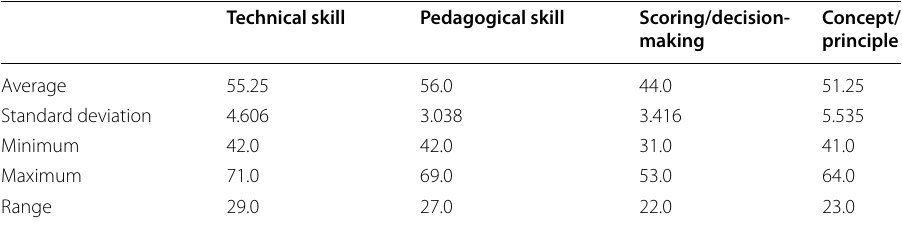
Table 2 Literacy levels in four different thematic areas of writing assessment